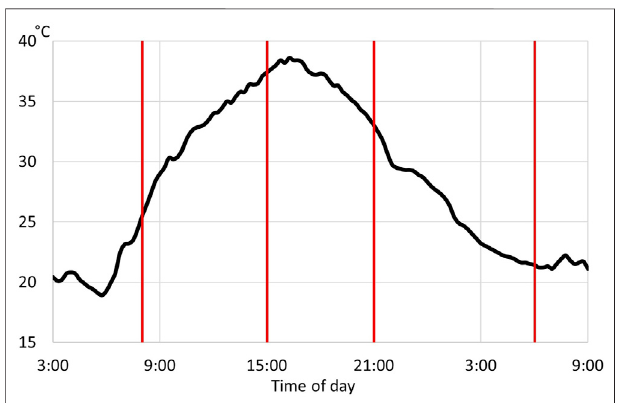
FIGURE 4 | Air temperature curve (black line) from 3:00 h on 30 June to 9:00 h on 1 July 2019 and temporal distribution of selected random forest models (red vertical lines). Air temperature pro fi le corresponds to weather station of the Leipzig University (IM station, cf. Figure 2